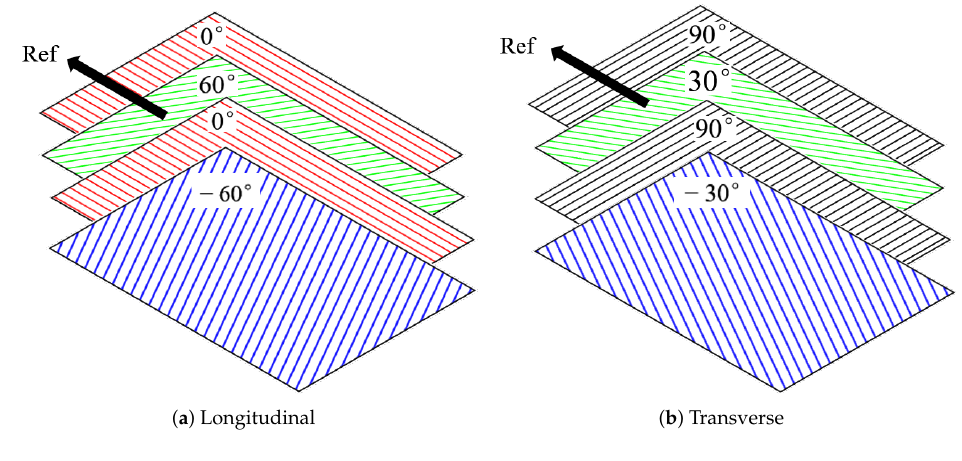
Figure 13. Two ways of uniaxial stretching.